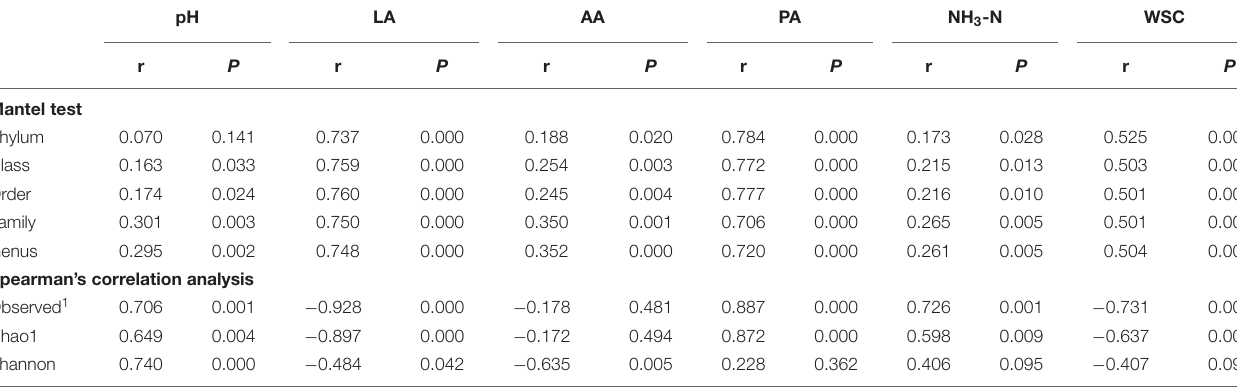
TABLE 2 | Correlation of bacterial community with fermentation properties in alfalfa silage illustrated by Mantel test and Spearman’s correlation analysis. pH LA AA PA NH 3